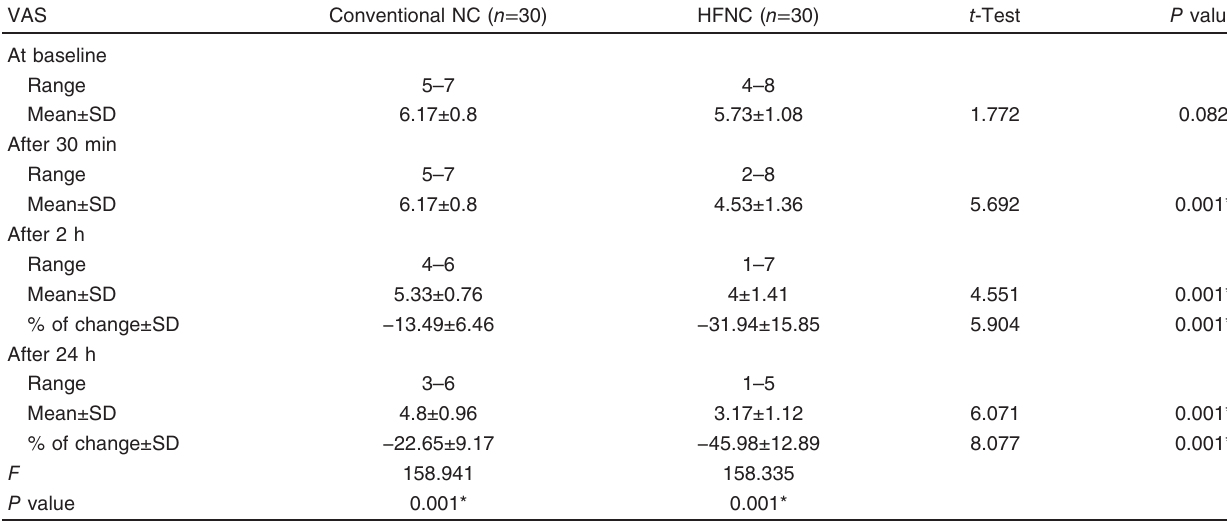
Table 3 Comparison of visual analog scale between the two studied groups VAS